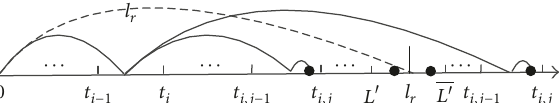
Figure 9: A failure replacement before only minor defective stage is